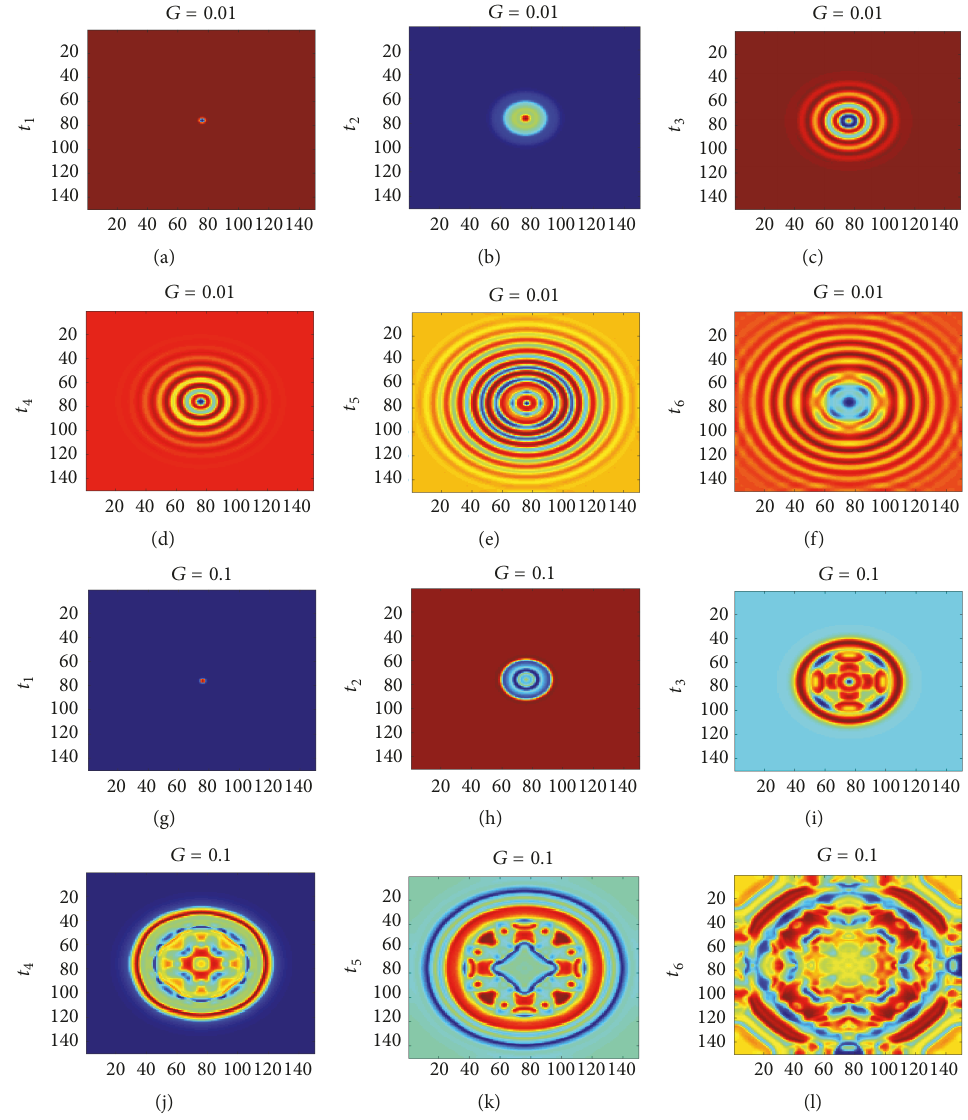
Figure 19: The snapshots of spatial distribution of membrane potential with color scale for neurons in the square array network for 𝑘 = 0.9 and 𝐷 = 1 at 𝑡 1 = 2 time units, 𝑡 2 = 75 time units, 𝑡 3 = 170 time units, 𝑡 4 = 300 time units, 𝑡 5 = 450 time units, and 𝑡 6 = 600 time units. ((a)–(f)) 𝐺 = 0.01 and ((g)–(i)) 𝐺 = 0.1